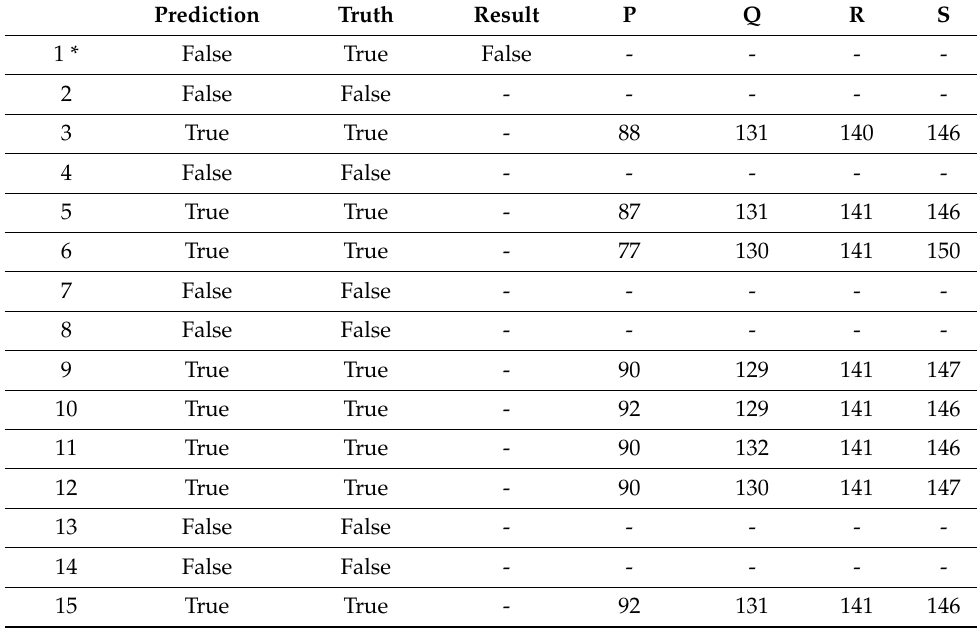
Table 2. Short extract from the PQRS peak